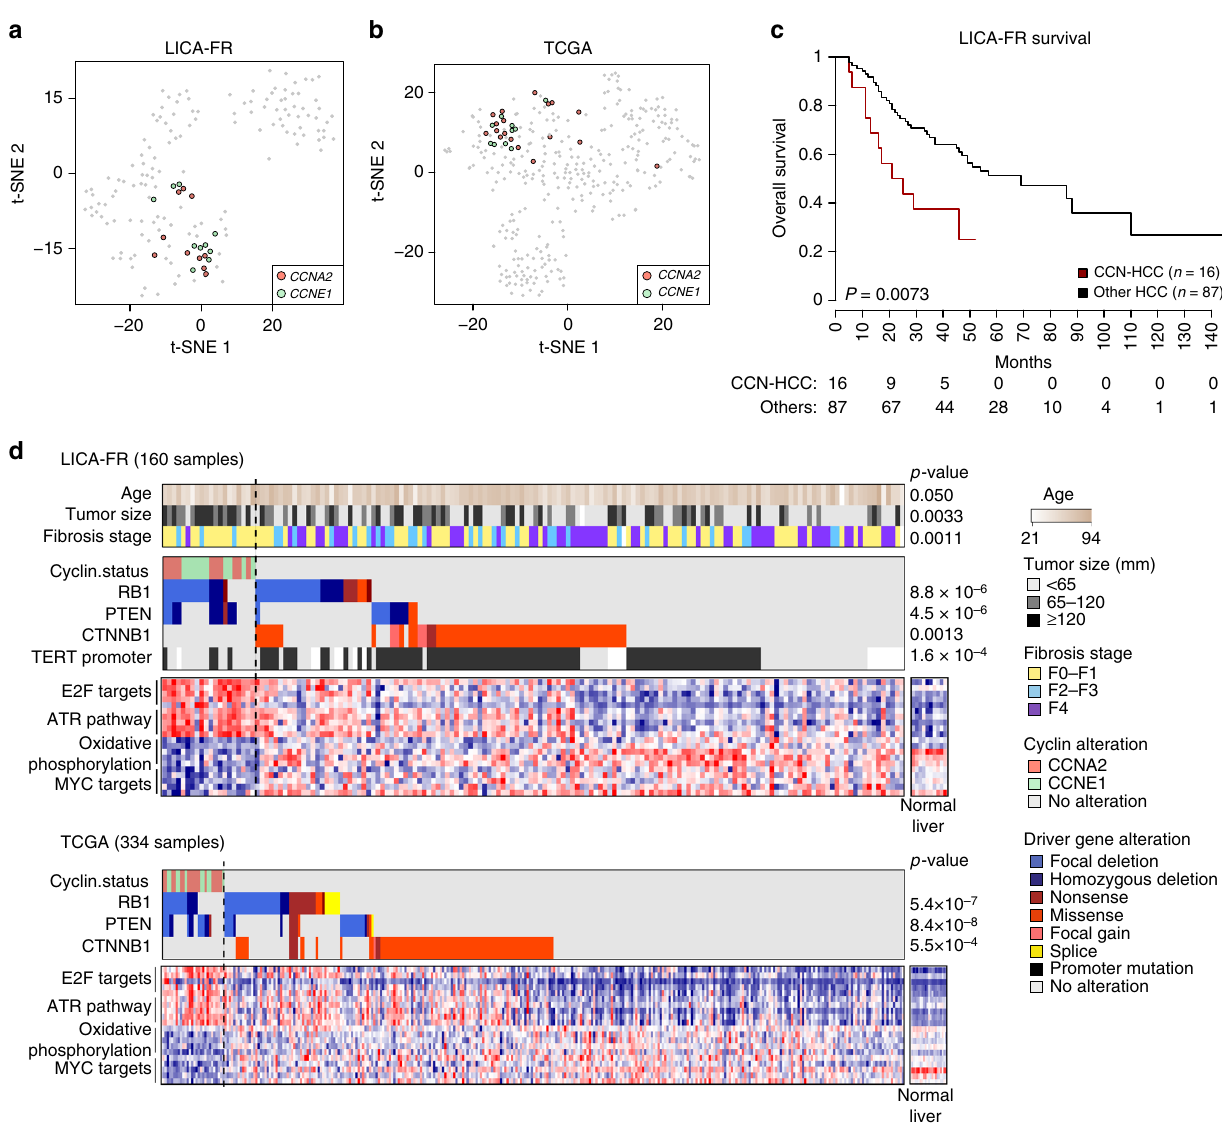
Fig. 3 Clinical and molecular features of cyclin-activated HCC. a t-SNE plots depicting the classi fi cation of HCC from the LICA-FR and TCGA cohorts based on their transcriptional pro fi les. Tumors harboring CCNA2 or CCNE1 activating alterations are indicated with a color code. b Clinical characteristics, driver genes and deregulated pathways associated with CCN-HCC in the LICA-FR (top) and TCGA (bottom) cohorts. c Overall survival in CCN-HCC as compared with other HCC in the LICA-FR cohort. Only HCC with curative resection (R0) were